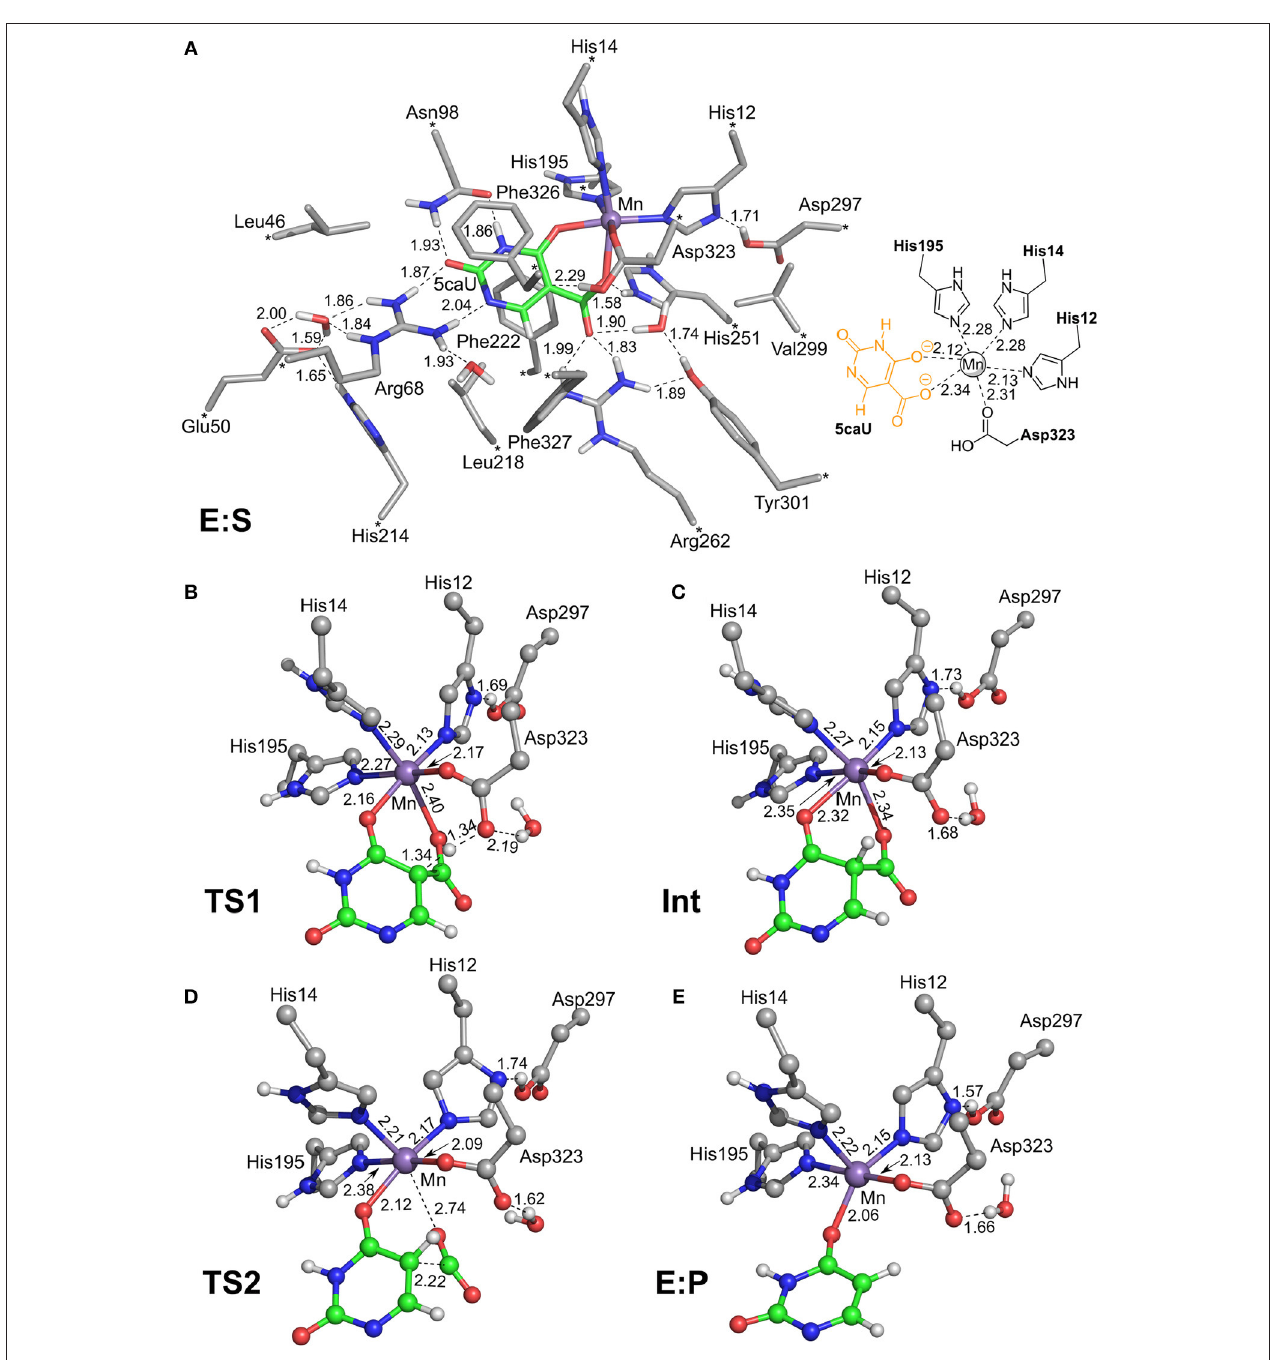
FIGURE 2 | Optimized structures of intermediates and transition states along the reaction pathway proposed for IDCase. (A) The enzyme-substrate complex E:S , (B) the TS for the protonation step, (C) the intermediate after the protonation step, (D) the TS for the C-C bond cleavage step, and (E) the enzyme-product complex E:P . For clarity, only polar hydrogen atoms and hydrogens on the substrate are shown, and the full model is only shown for E:S . The atoms fixed during geometry optimization are marked with asterisks in E:S and selected distances are given in Å.